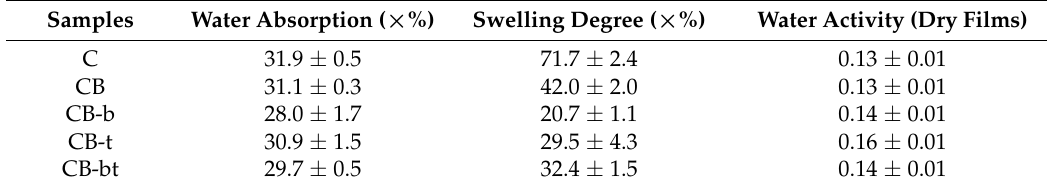
Table 2. WVA, SD, and WA of C, CB, CB-b, CB-t, and CB-bt.